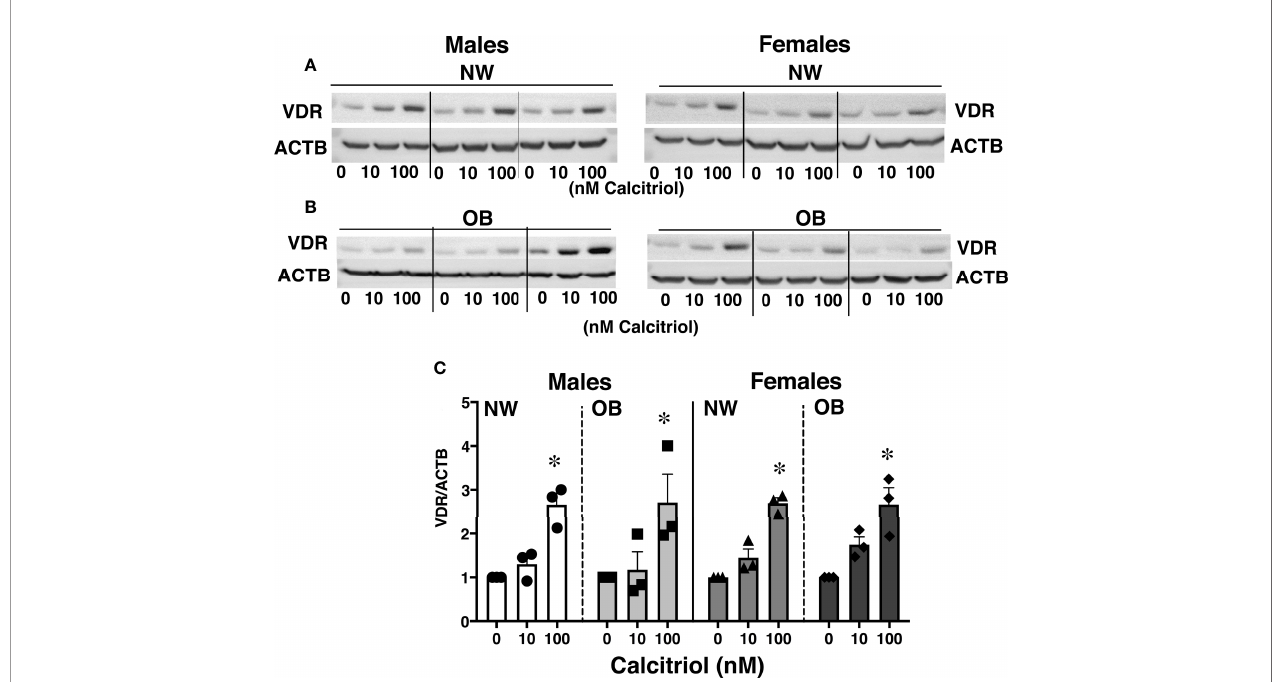
FIGURE 3 | Effect of 24-hour treatment with calcitriol, an active form of Vitamin D, on expression of VDR in primary trophoblasts isolated from placentae of NW and OB women. Representative Western blots (A, B) and quanti fi cation data (C) demonstrating a dose-dependent response to treatment. Data were normalized to b -actin (ACTB) and expressed as fold-change relative to untreated cells. *, p < 0.05. N=3-5/dose/group/fetal